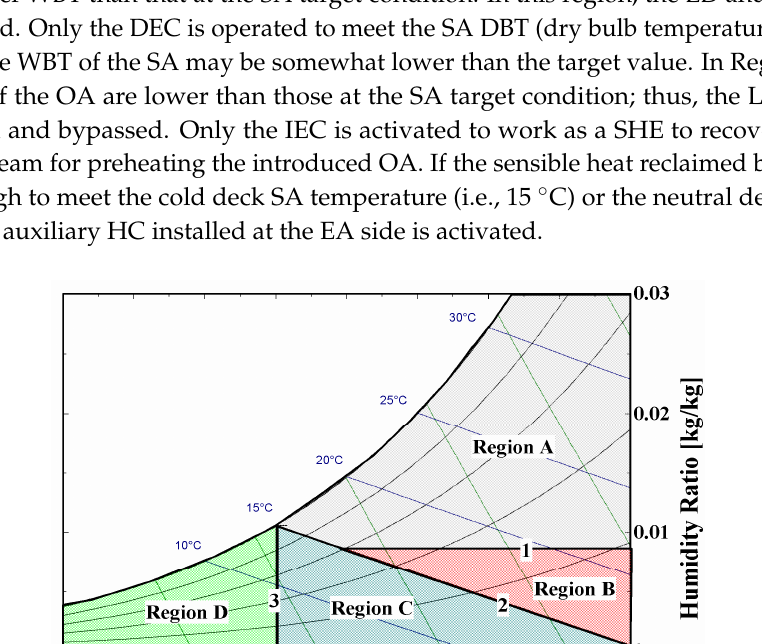
Table 1. Operation mode and relevant components [2].